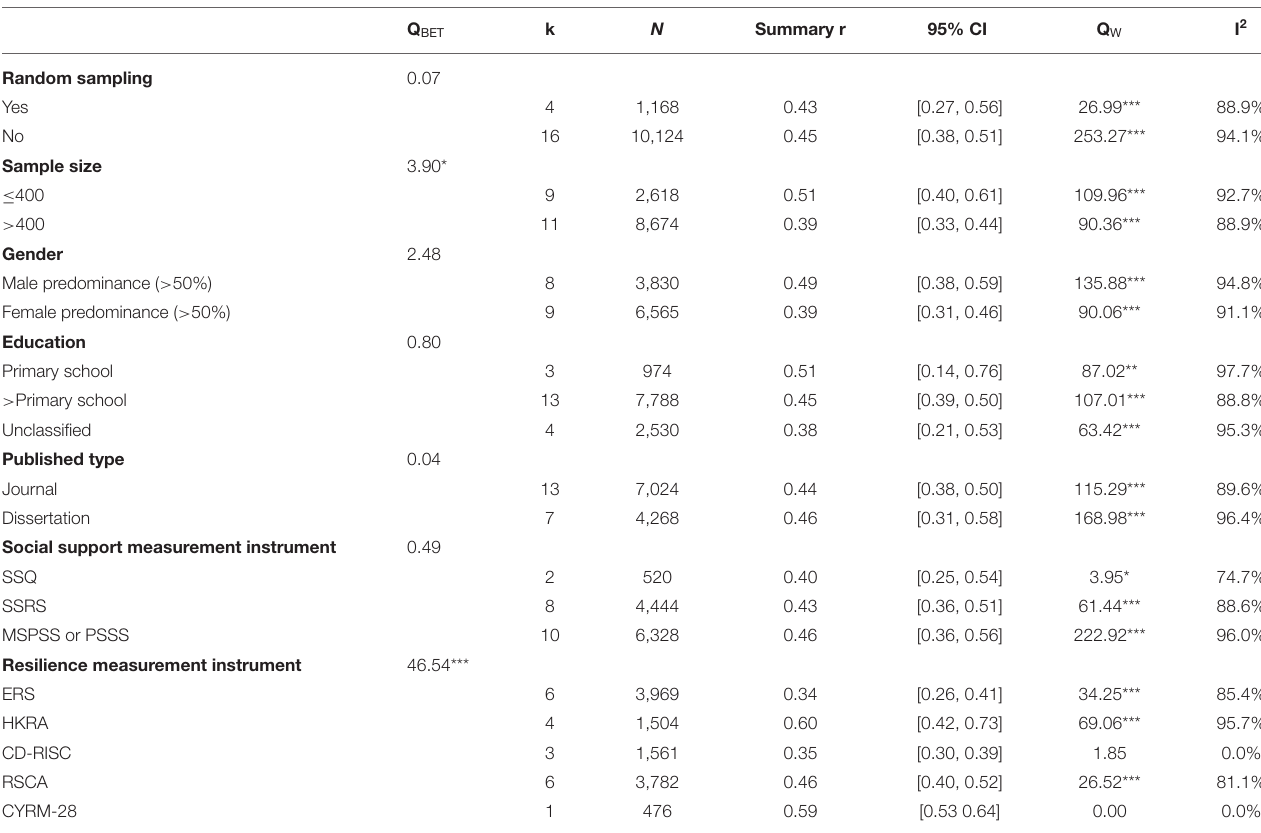
TABLE 4 | Subgroup analyses of the summary correlation between social support and resilience among LBC. Q BET k N Summary r 95%